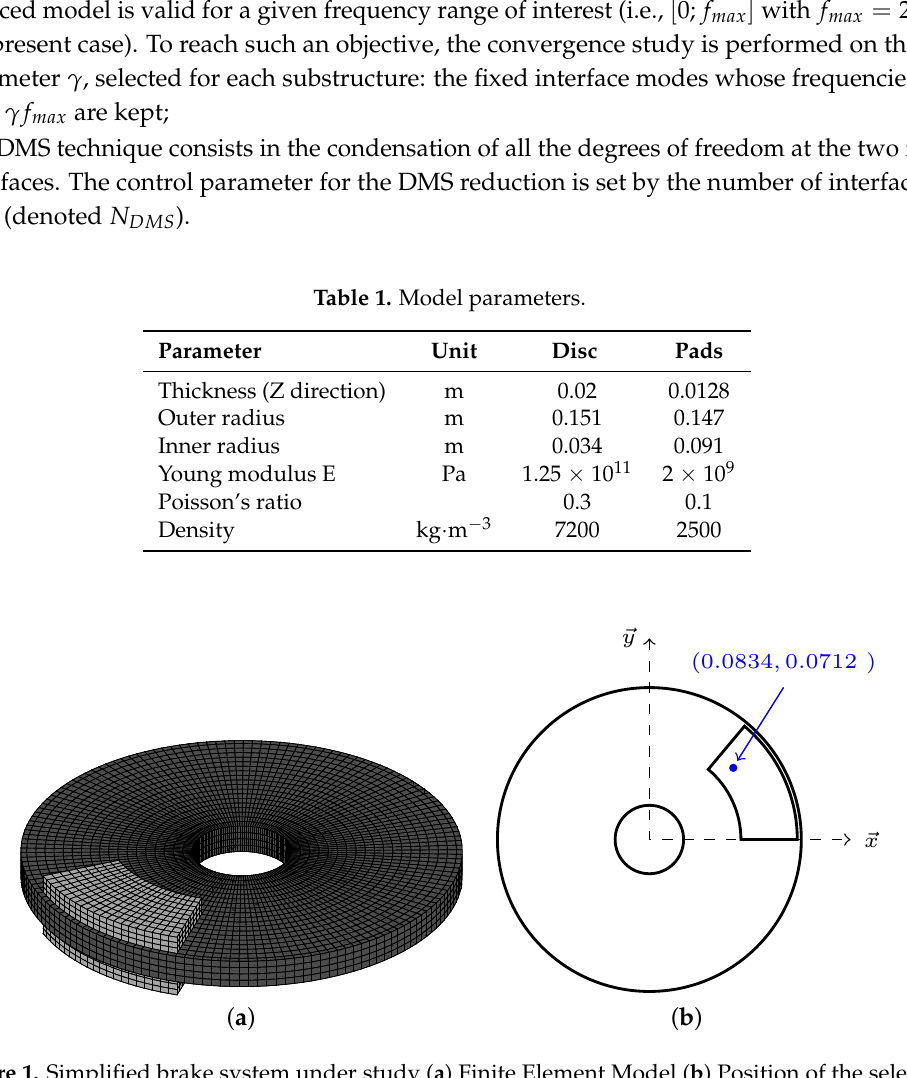
Figure 1. Simplified brake system under study ( a ) Finite Element Model ( b ) Position of the selected point for the description of the nonlinear dynamic